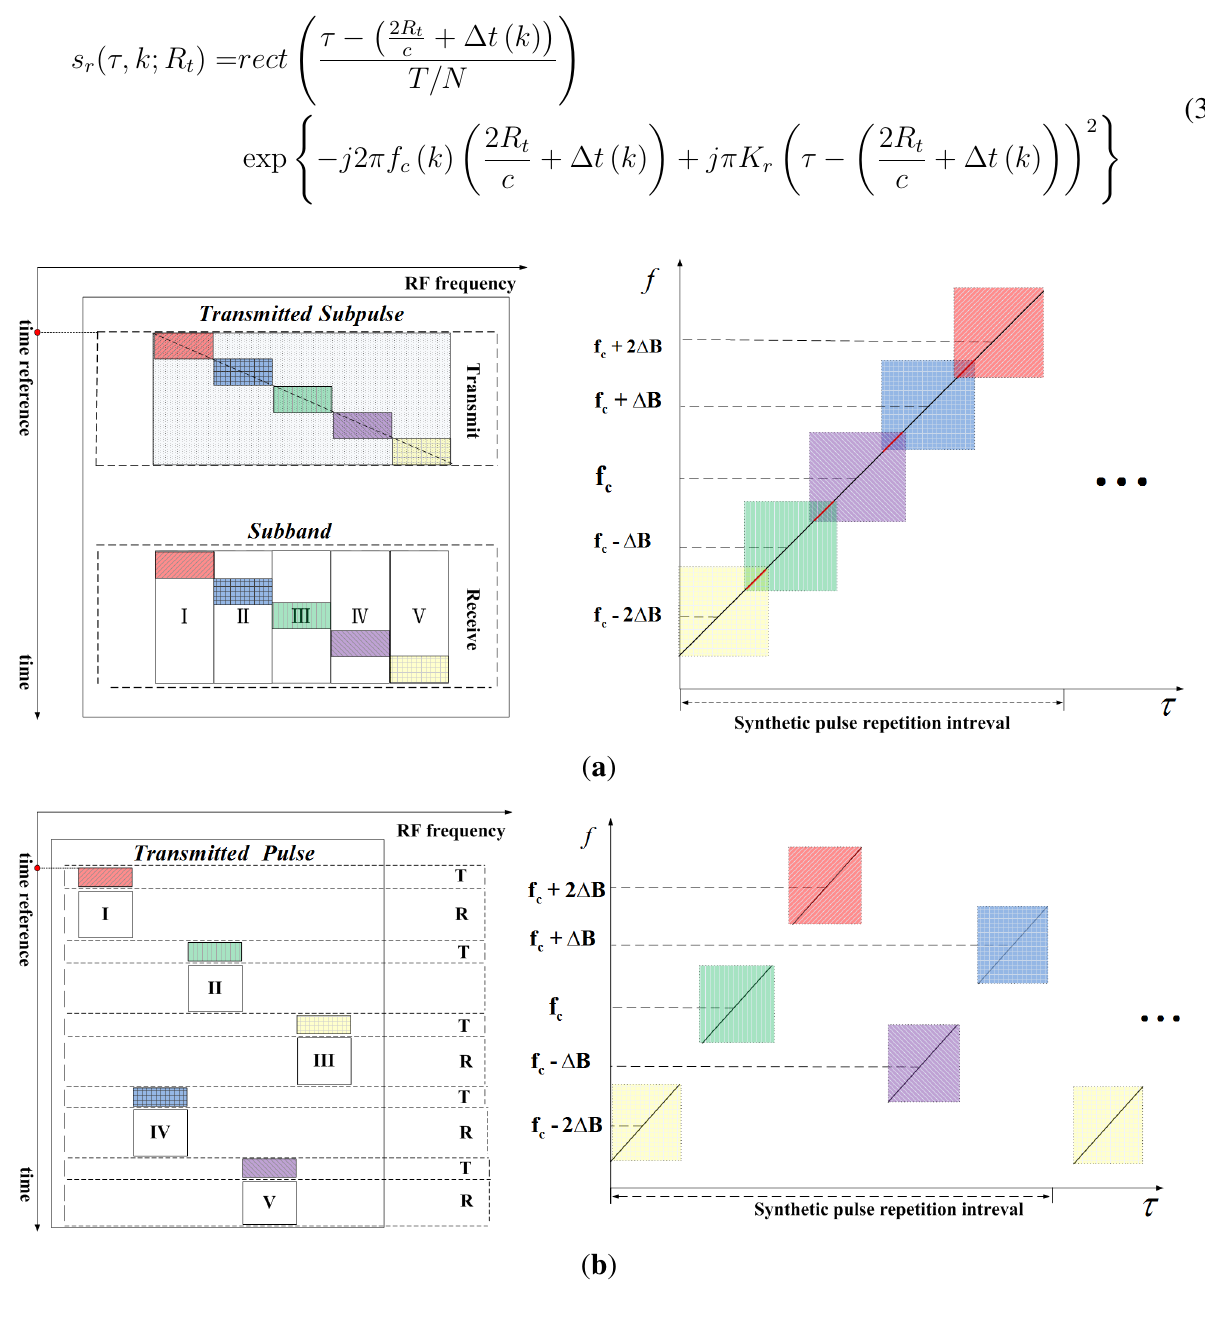
Figure 1. Schematic diagram and time-frequency diagram (TFD) in the range direction of two operation modes of a multi-sub-band system. ( a ) Consecutive stepped-frequency mode; ( b ) non-consecutive stepped-frequency